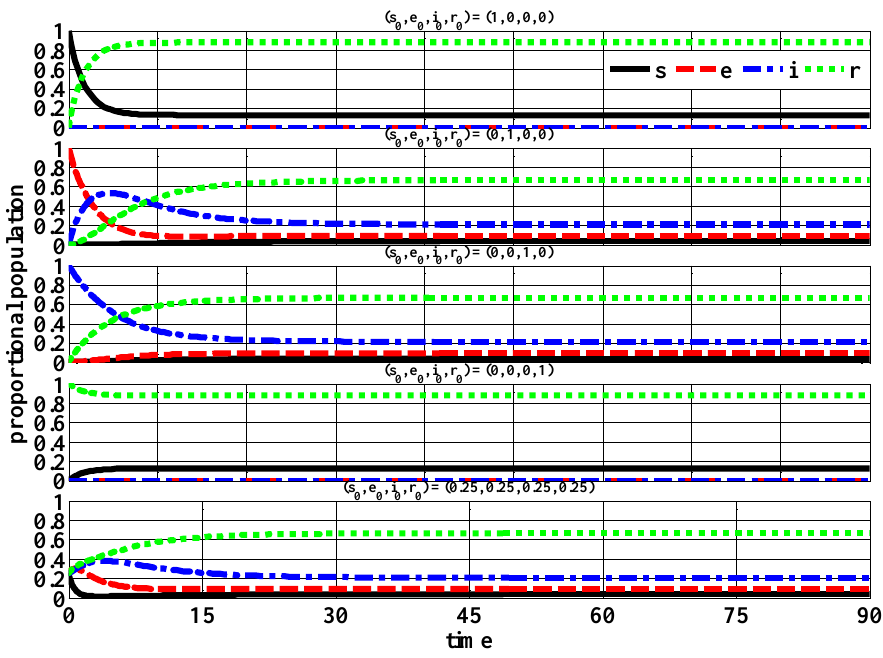
Figure 4. Proportional Populations (β = 4 (Epidemic)).